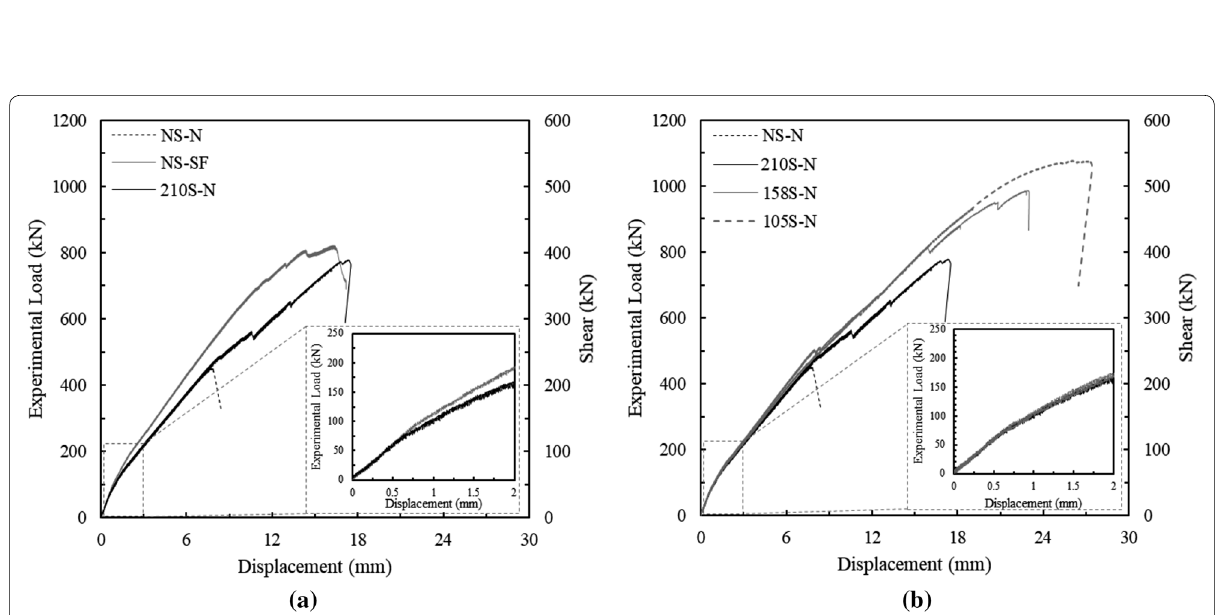
Fig. 5 Mechanical test results; a results of four‑point flexural strength test, b results of three‑point flexural strength test, and c results of single fiber pullout test.